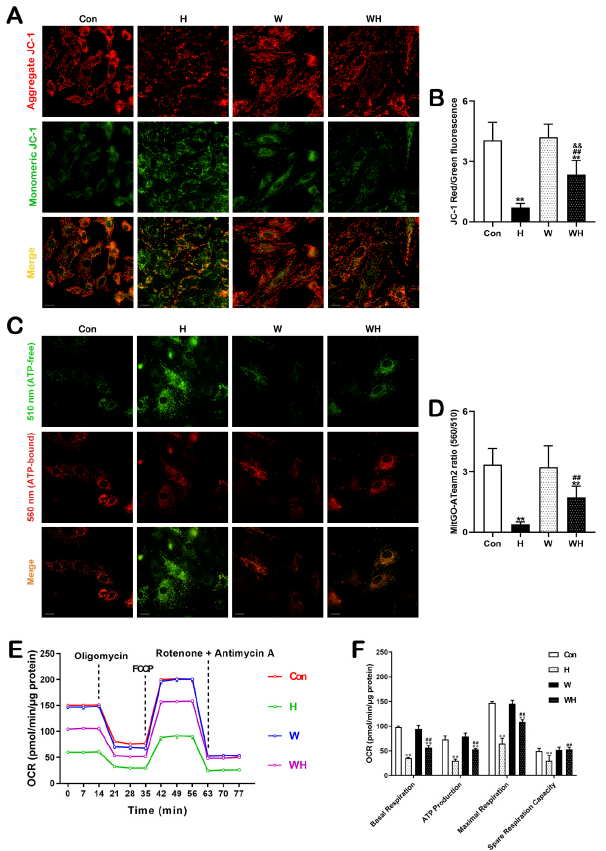
Figure 8. WA maintained the MMP and restored ATP production in the mitochondria of cardiomy- ocytes. ( A ) Representative immunofluorescence images of JC-1 staining; red fluorescence indicates JC-1 aggregates, and green fluorescence indicates monomeric JC-1. Scale bars = 20 µ m. ( B ) Statistical analysis of the MMP, presented as the ratio of aggregated to monomeric JC-1. ( C ) Representative immunofluorescence images of cardiomyocytes transfected with MitGO-ATeam2. Scale bars = 20 µ m. ( D ) Quantitative analysis of mitochondrial ATP levels, as indicated by the ratio of emission at 560 nm to that at 510 nm. ( E ) Line graph and statistical analysis of OCR. ( F ) Quantification of basal respi- ration, ATP production, maximal respiration, and spare respiration. The data are presented as the mean ± SEM values. In ( A ) and ( C ), n > 20 fields from three independent experiments; in ( E ), n = 5. ** p < 0.01 vs. the Con group. ## p < 0.01 vs. the H group. && p < 0.01 vs. the W